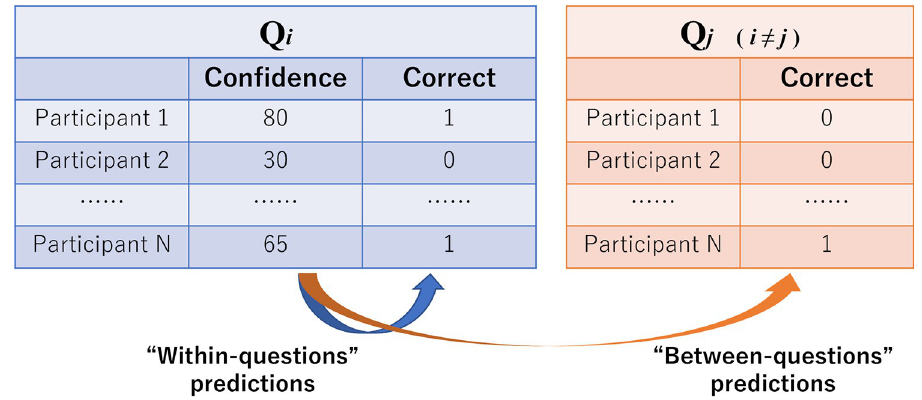
Fig 3. Schematics of the procedure of analyses of behavioral data. From confidence in Question i , we predicted accuracy (correct or false) in Question i in “within-questions” cases or accuracy in Question j ( i 6¼ j ) in “between- questions”